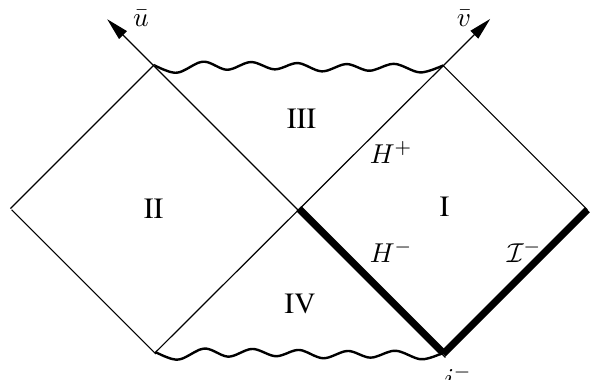
Figure 2. Penrose diagram of the maximally-extended BH spacetime. The tortoise coordinates ( t, x ) cover the exterior region I. The conditions defining different vacua in the BH background will be imposed on the past boundary of this region consisting of the past horizon H − , past time-like infinity i − and past light-like infinity I − (marked by the thick